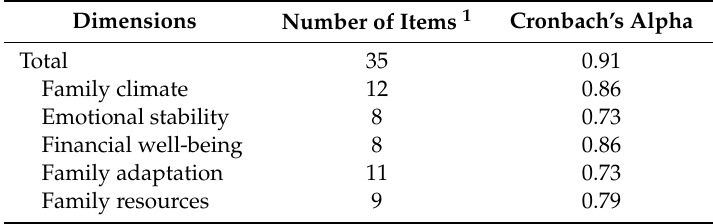
Table 3. Cronbach’s alpha of each dimension of the CdVF-ER < 18